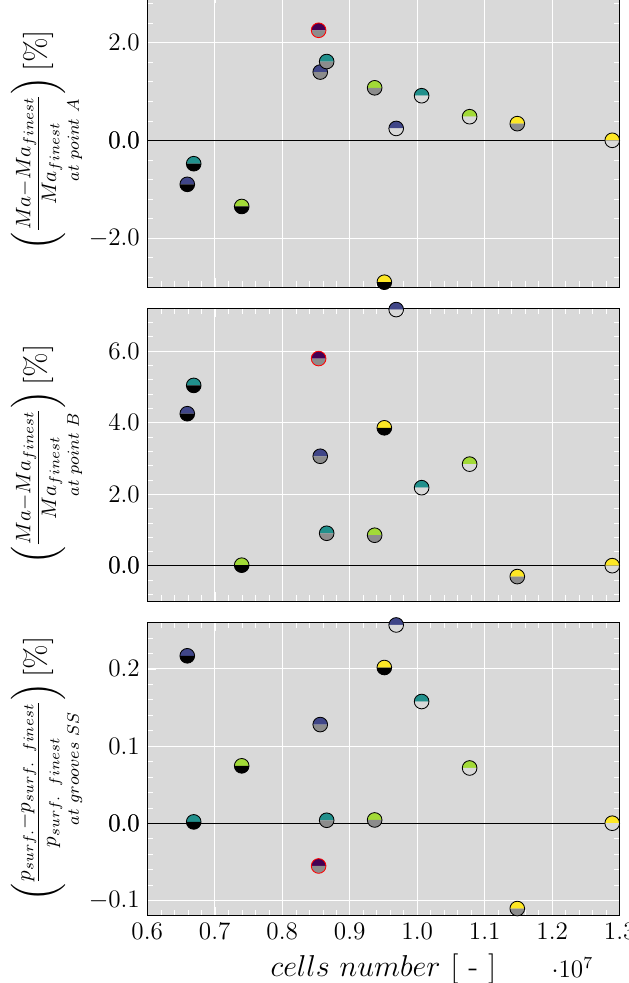
Figure 6. Mesh analysis Part B. The red dot corresponds to the mesh parameters used with the case without